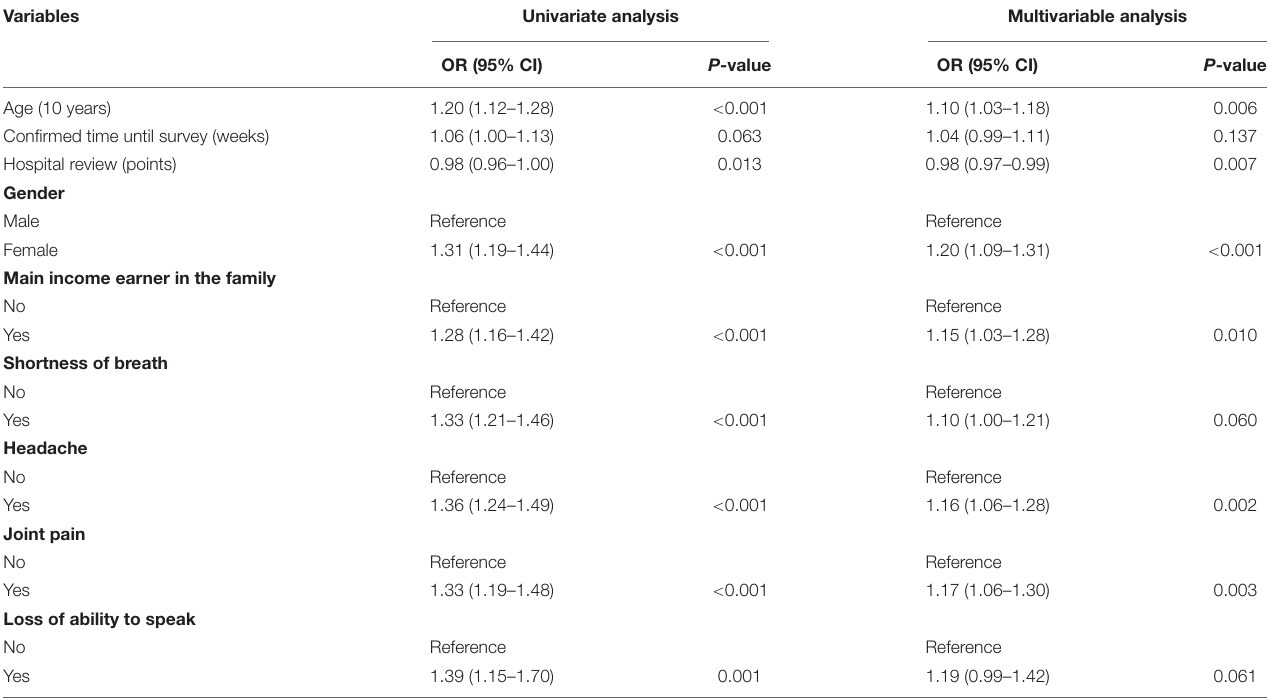
TABLE 3 | Multivariable regression related to indications for high anxiety and depression (HAD)